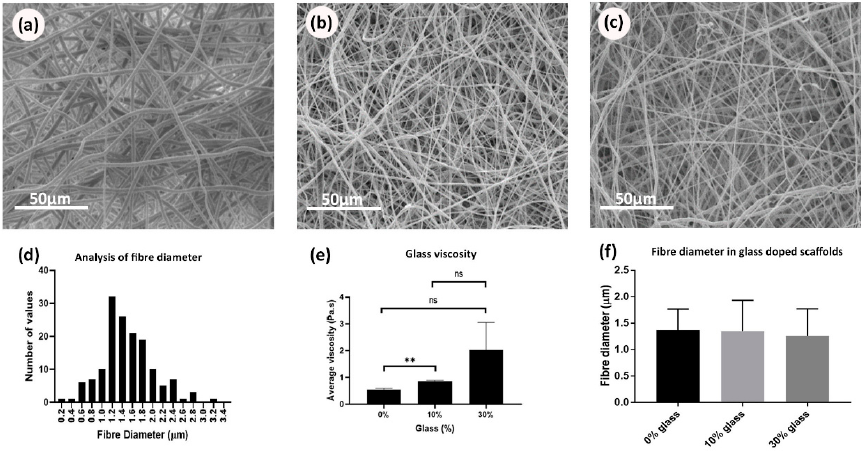
Figure 5. SEM micrographs of PCL/BG plain samples showing the effect of BG concentration on fiber fiber morphology and diameter measurements: ( a ) PCL / 0% BG; ( b ) PCL / 10% BG; ( c ) PCL / 30% BG; morphology and diameter measurements: ( a ) PCL/0% BG; ( b ) PCL/10% BG; ( c ) PCL/30% BG; ( d ) analysis of fiber diameter from electrospun scaffolds by use of a histogram showing size distribution; ( d ) analysis of fiber diameter from electrospun sca ff olds by use of a histogram showing size distribution; ( e ) bar graph showing the effect of the BG concentrations on the average viscosity of the PCL/BG ( e ) bar graph showing the e ff ect of the BG concentrations on the average viscosity of the PCL / BG solutions; ( f ) bar graph showing the effect of BG concentrations on the fiber diameter. solutions; ( f ) bar graph showing the e ff ect of BG concentrations on the fiber